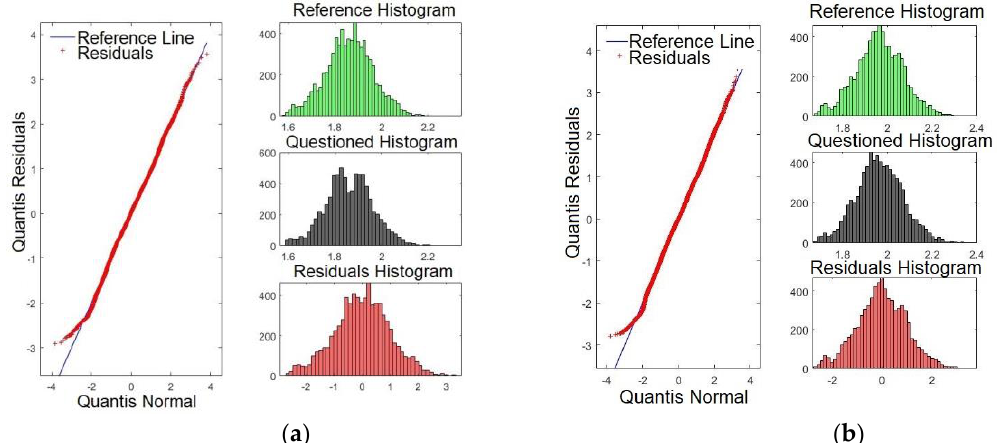
Figure 10. Q-Q plot of the formants comparing the confronted with the reference audios: (a) formant F17 and (b) formant F18 .